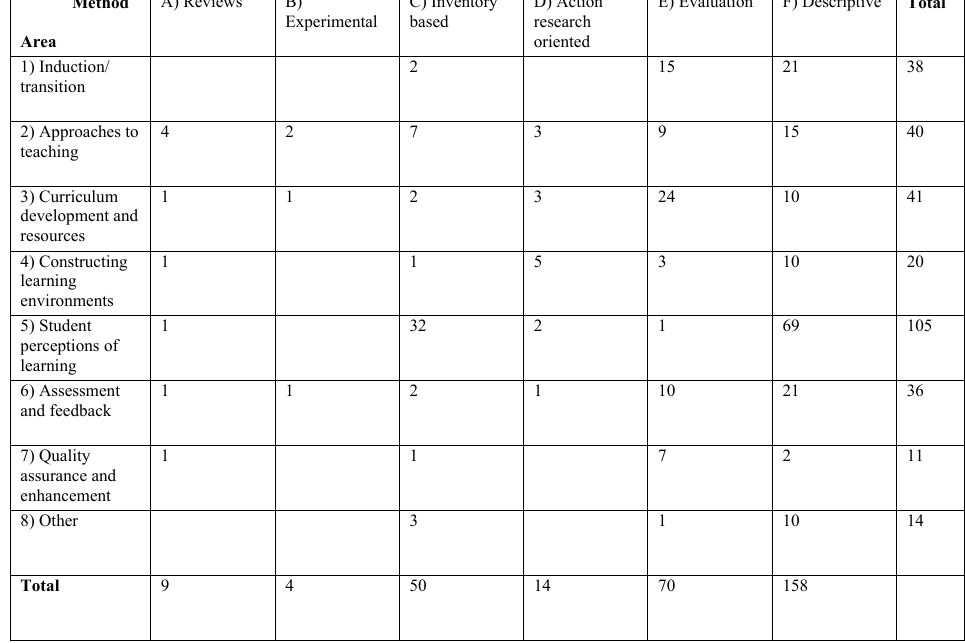
Figure 1. Analytical